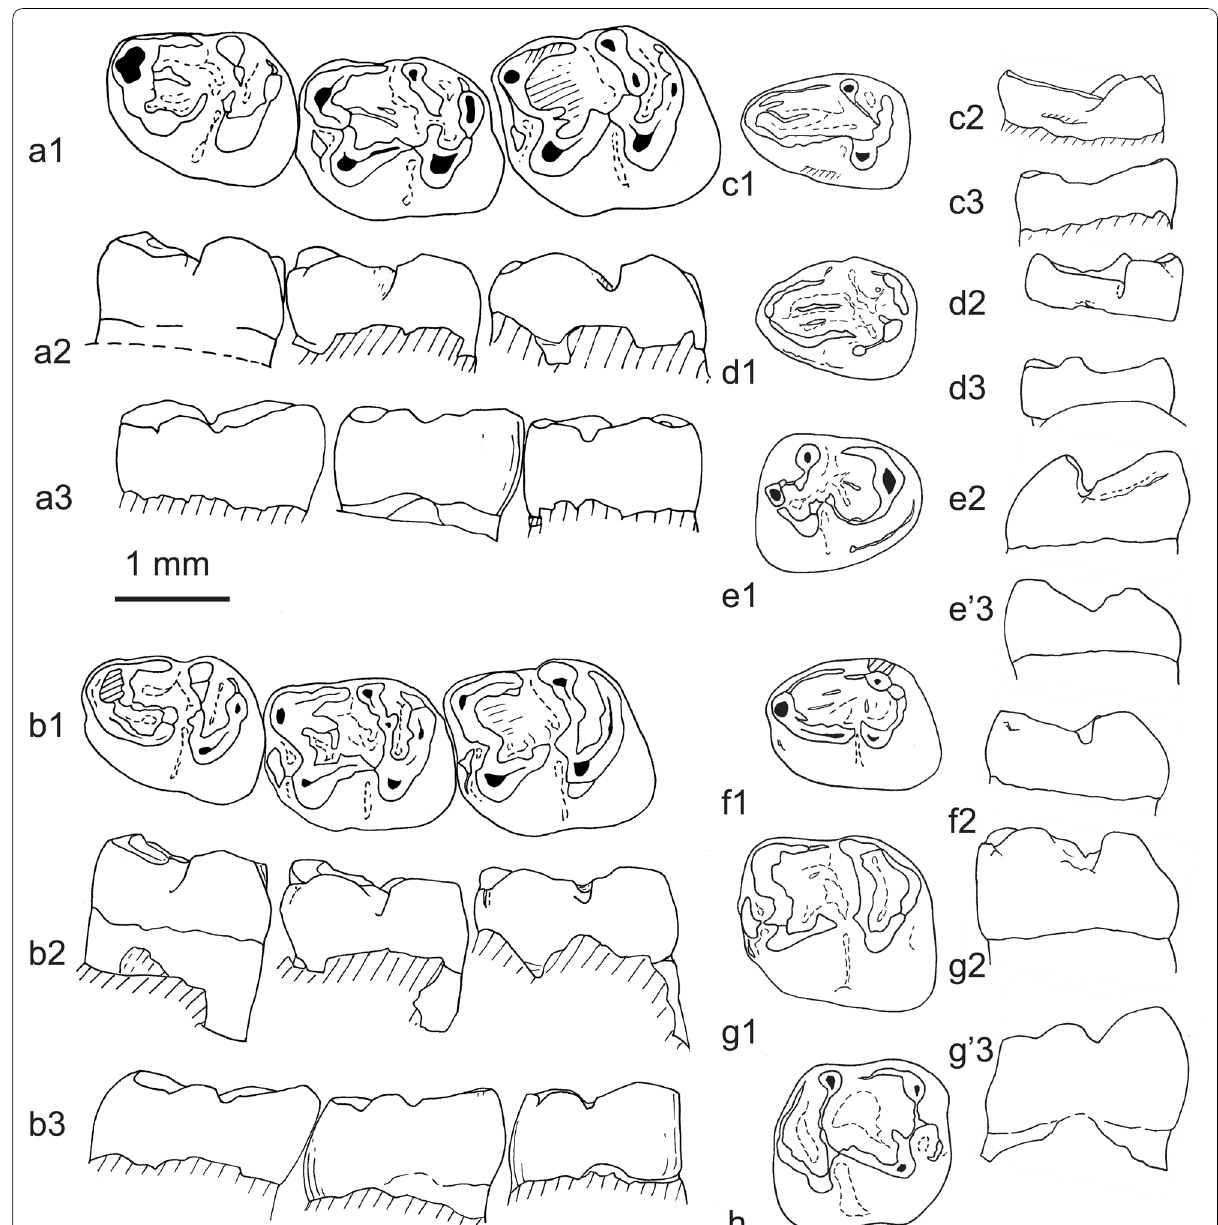
Fig. 9 Lower teeth of Protadelomys cartieri (Stehlin & Schaub, 1951), from Egerkingen (Swiss Jura). a Ek H002, left p4–m2; a1, occlusal view; a2, buccal aspect; a3, lingual aspect. b : Ek H002‑4, left p4–m2; b1, occlusal view; b2, buccal aspect; b3, lingual aspect. c : Ek 80, left dp4, nearly unworn; c1, occlusal view; c2, buccal aspect, c3: lingual aspect. d Ek 81, left dp4, nearly unworn; d1, occlusal view; d2, buccal aspect, d3, lingual aspect. e: Ek 67, right p4, moderately worn; e1, occlusal view; e2, buccal aspect; e3, lingual aspect. f Ek 77, left p4, weakly worn; f1, occlusal view; f2, buccal aspect. g Ek 70, left m2?, weakly worn; g1, occlusal view; g2, buccal aspect; g3, lingual aspect. h Ek 69, right m2?, weakly worn; occlusal view. Scale bar 1 =